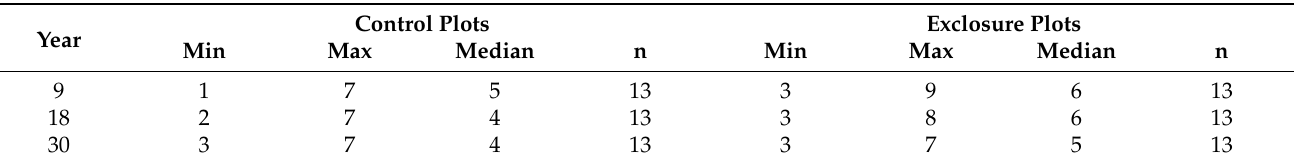
Table 1. Descriptive statistics (min, max, median) of species richness (number of tree species detected) within the 13 control and exclosure plot pairs, depicted for three points of time within the 30-year study period.